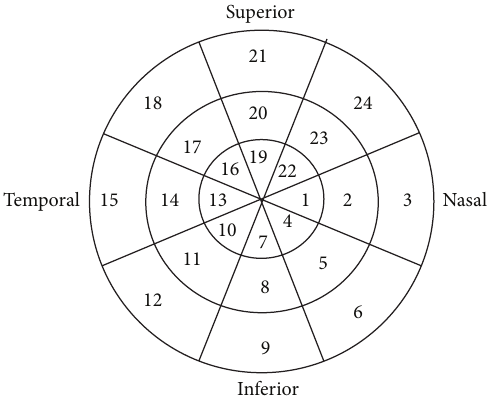
Figure1:ApapillaryimagewasdividedautomaticallybytheLaguna ONhE (optic nerve head hemoglobin) device into eight 45 ∘ radial sectors and two concentric rings comprising 1/3 and 2/3 of the disc radius. The Laguna ONhE program analyzed the amount of hemoglobin in each of these 24 sectors and the average